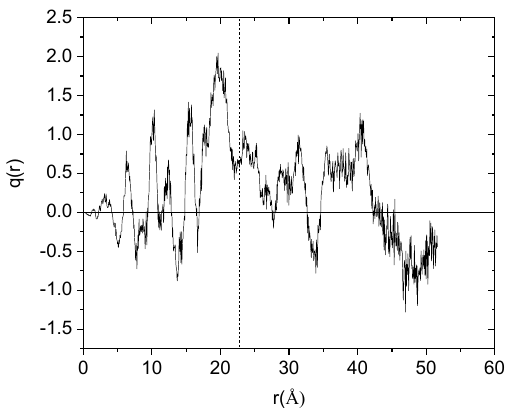
Figure 6. Overall charge distribution with respect to the HBP center of mass arising from all the components in the system. The vertical dashed line denotes the surface boundary of the hyperbranched nanoparticle.